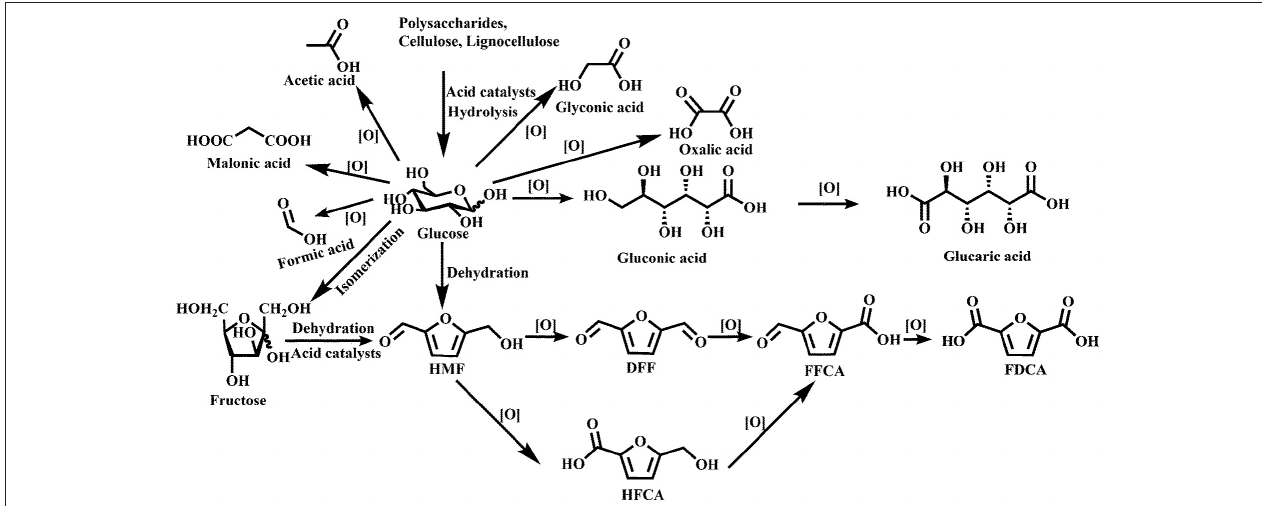
FIGURE 5 | Chemicals produced by oxidation of glucose and glucose-derived molecules. Used with permission of Royal Society of Chemistry, from Zhang and Huber (2018); permission conveyed through Copyright Clearance Center, Inc.